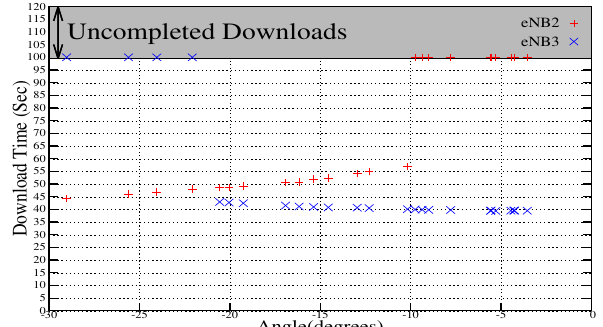
Figure 4: Download time Vs angle